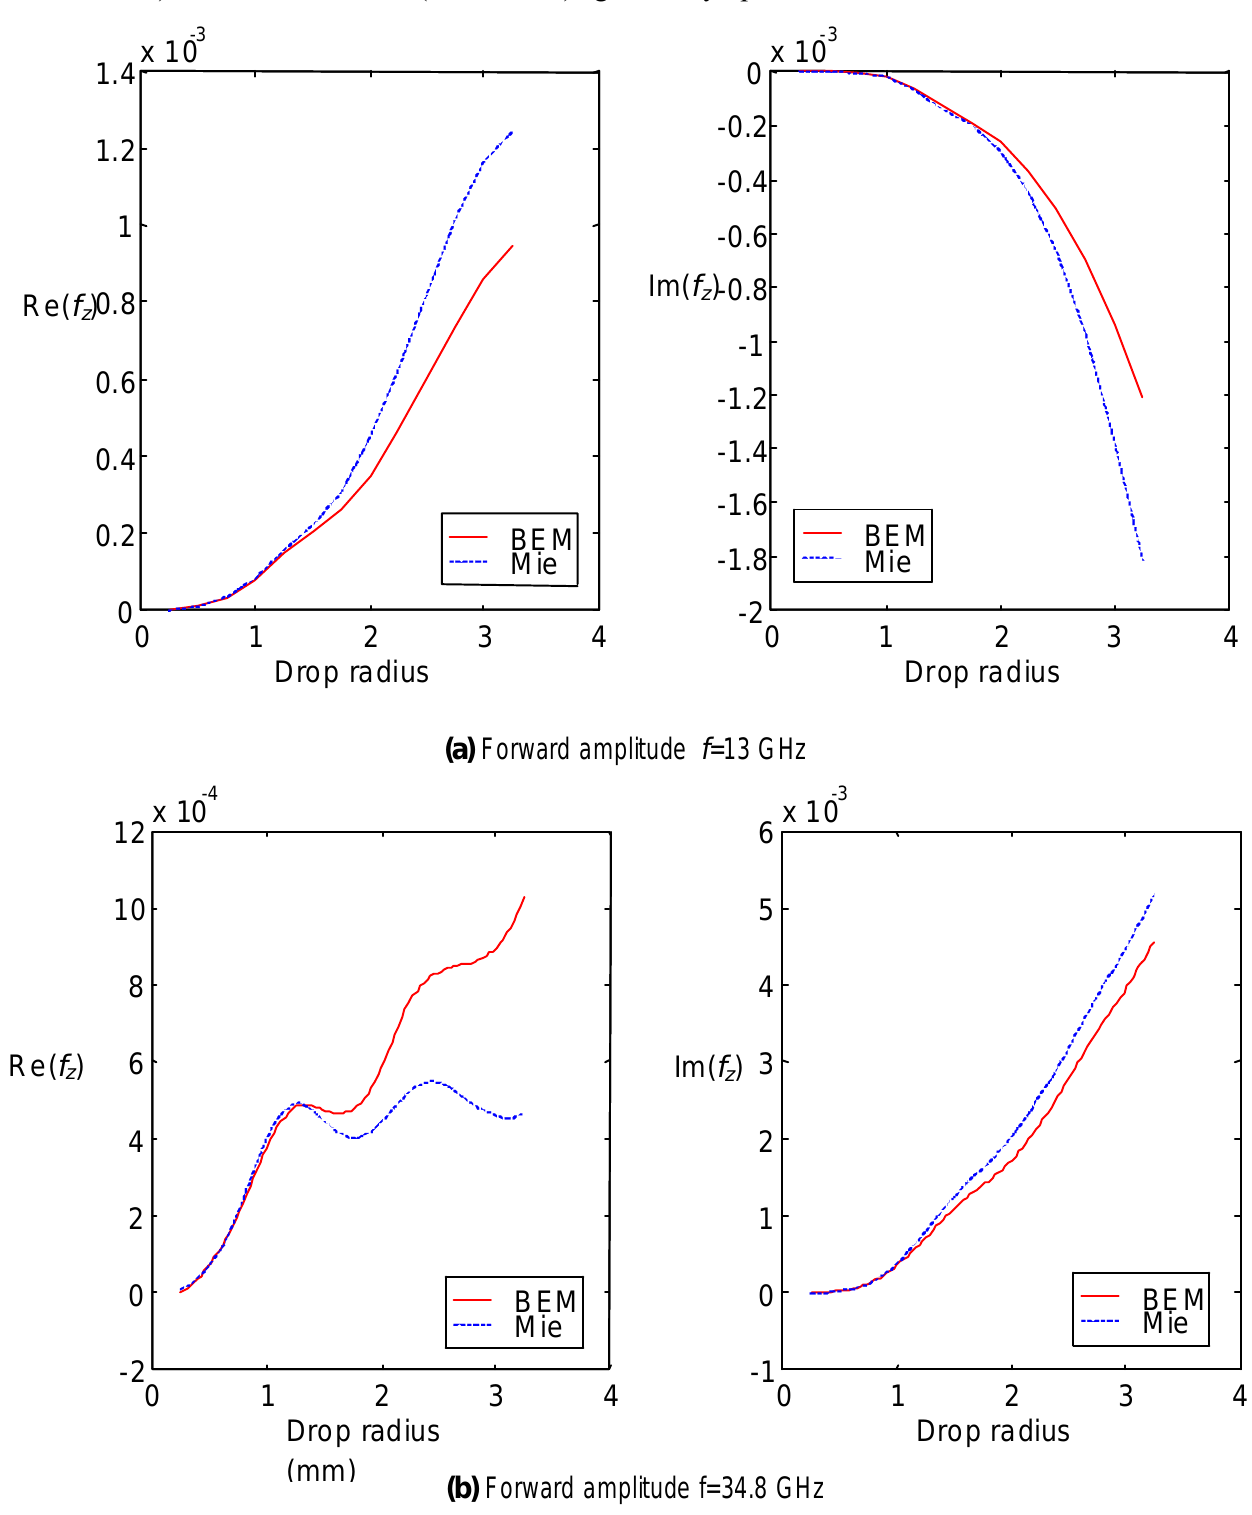
Figure 6. Real and imaginary parts of the amplitude scattering functions vs. raindrop radii at 13 and 34.8 GHz. Direction of propagation of the incident wave: ˆ x , vertical polarization ( ˆ z ). BEM solution (solid line) shows an excellent agreement with Oguchi 1977 [17] (not shown), while Mie solution (dashed line) agrees only up to 1 to 1.5 mm